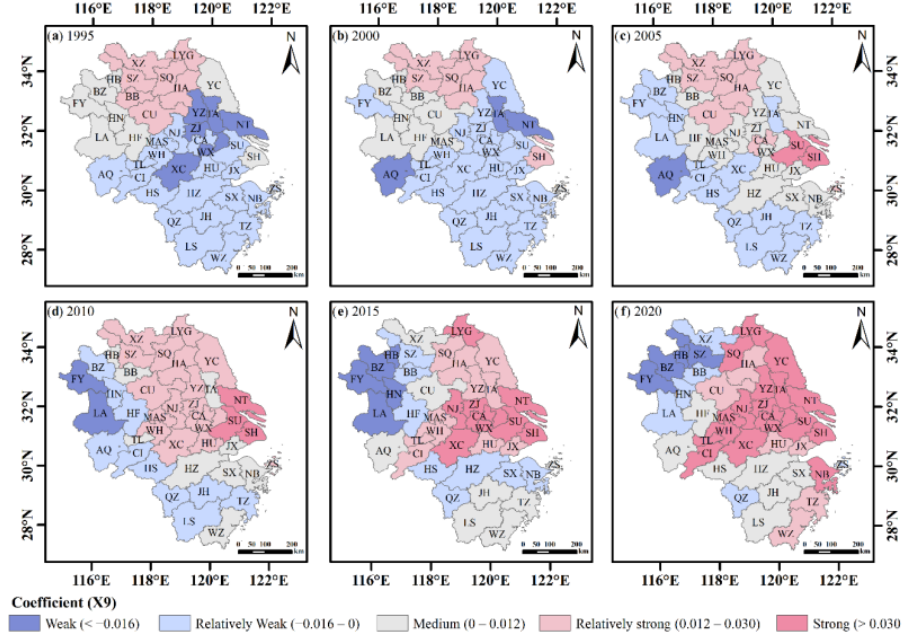
Figure A9. Spatial distribution of the regression coefficients of the carbon emission intensity.